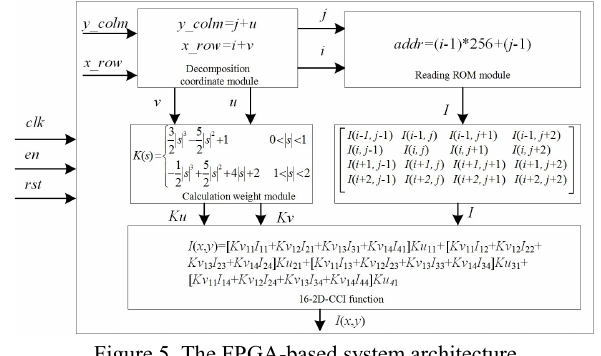
Figure 5. The FPGA-based system architecture 4.1 Parallel Decomposition of ( x _ row , y _c olm ) Coordinate